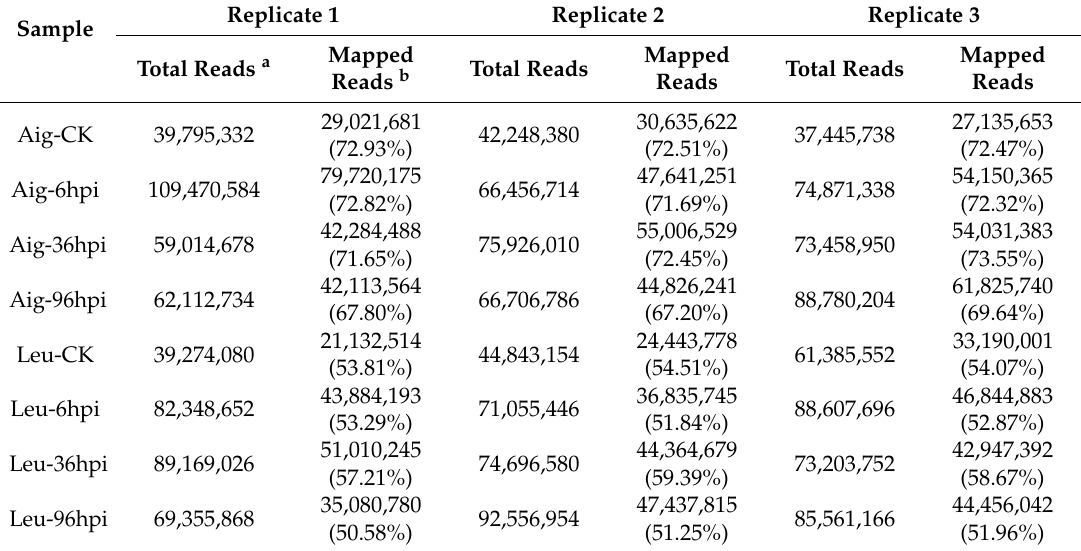
Table 1. Statistics of reads mapped onto the poplar reference genomes.